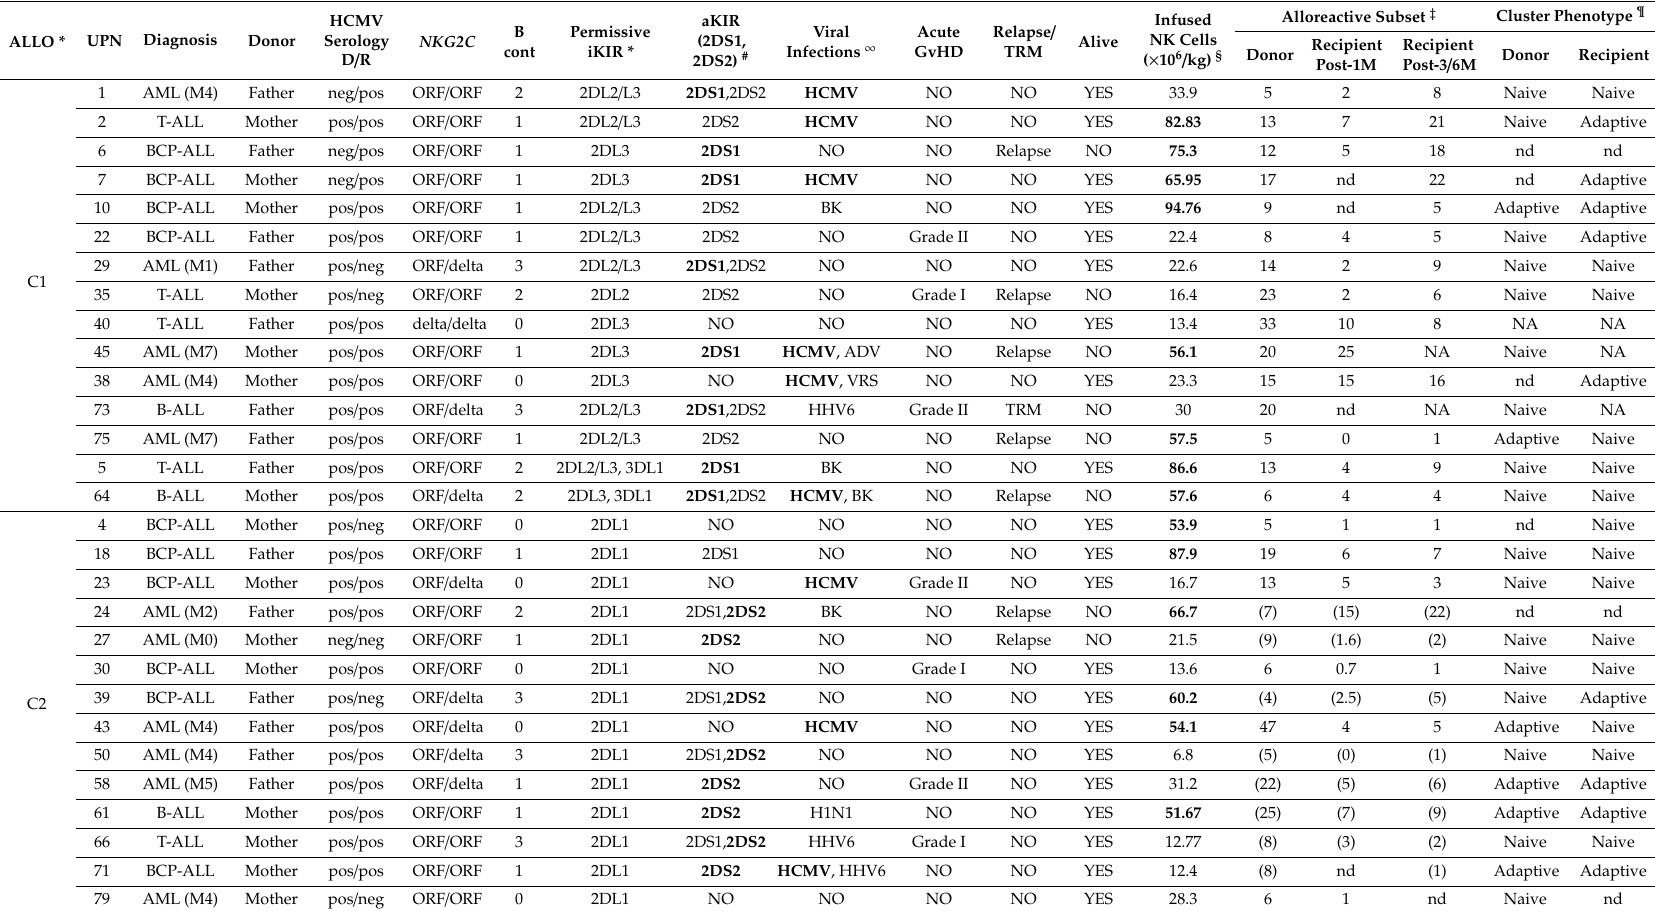
Table 1. Description of cases transplanted from NK alloreactive